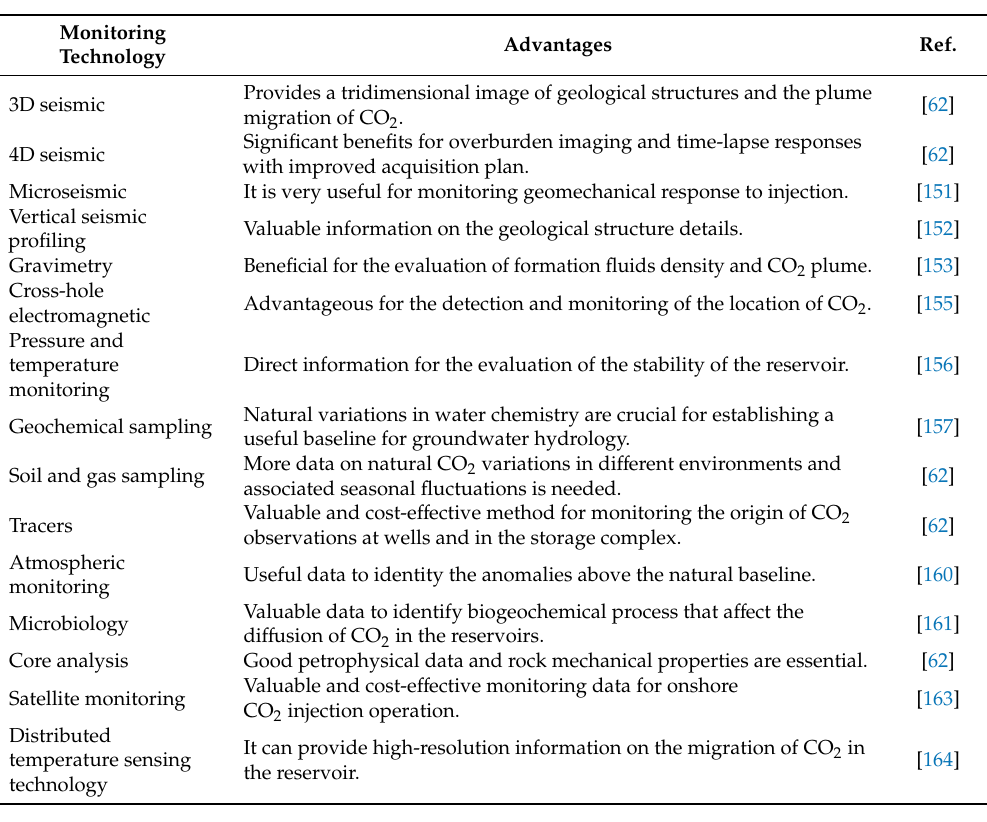
Table 4. Main monitoring technologies in